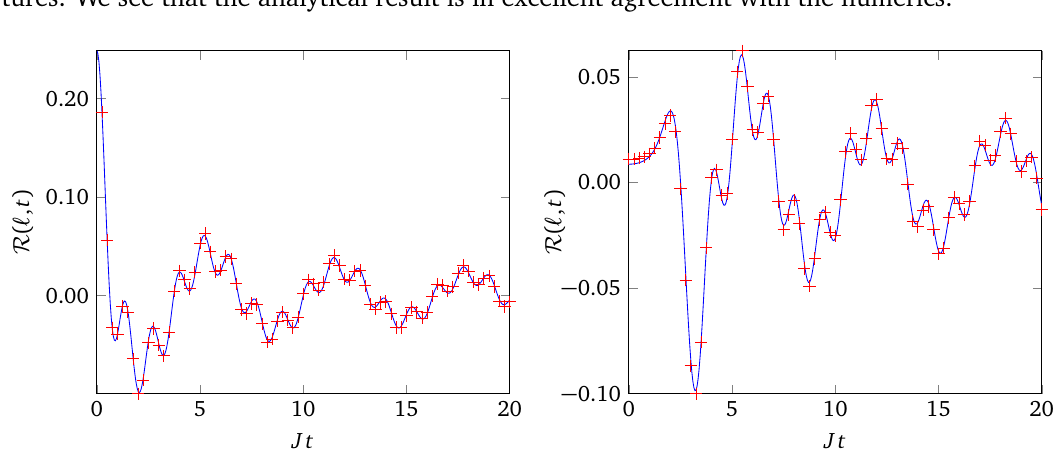
Figure 15: R ( (cid:96) , t ) as a function of t with h = 1.5 and β = 3 for (cid:96) = 0 (left) and (cid:96) = 5 (right). Numerical results for a L = 200 site open chain are shown as red crosses and equation (150) as a solid blue